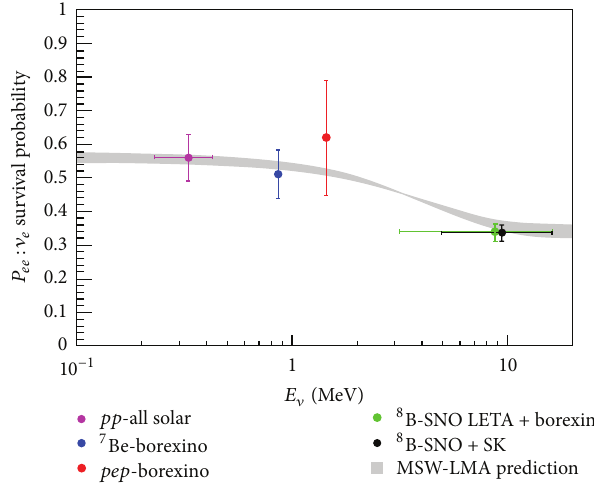
Figure 18: The 𝜈 𝑒 survival probability is represented as a function of neu-trino energy. The gray band represent the MSW-LMA prediction. The higher survival probability region at low energies is where vacuum-dominated oscillations occur. As the neutrino energy increases, matter effects become important and the lower survival probability at high energies is due to matter-enhanced oscillations. The reported data correspond to solar neutrino flux measurements performed by different experiments. Taken from